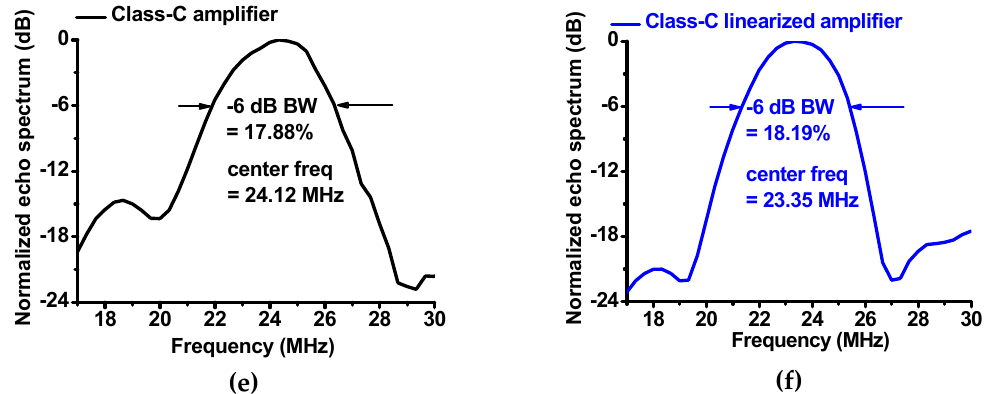
Figure 7. ( a ) Schematic diagram and ( b ) photo of the pulse-echo measurement; echo signal amplitudes generated by piezoelectric transducer when using ( c ) class-C amplifier and ( d ) class-B linearized amplifier. Normalized spectrum of the echo signal amplitudes generated by the piezoelectric transducer when using ( e ) class-C amplifier and ( f ) class-C linearized amplifier. BW and center freq represent the –6 dB bandwidth and center frequency of the echo signals, respectively.